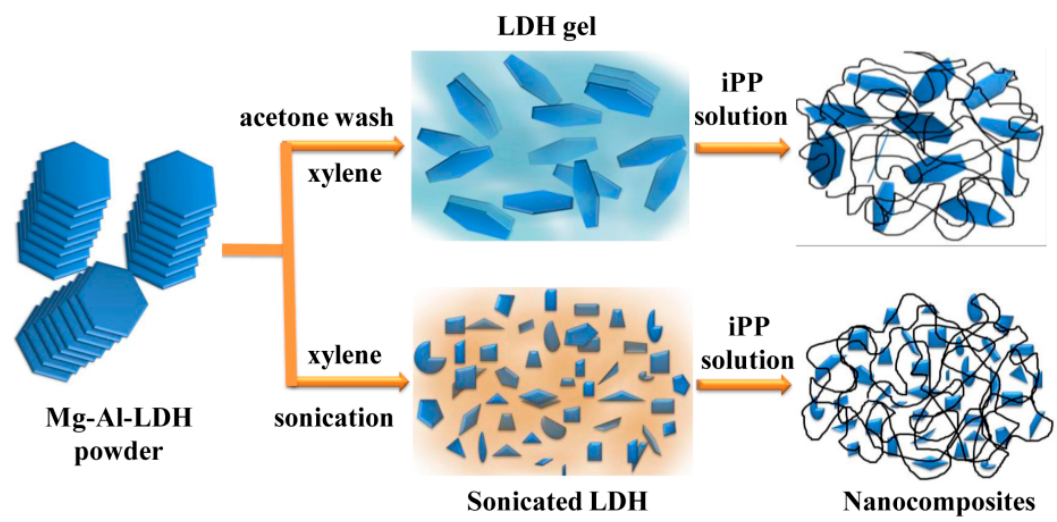
Figure 3. Graphic representation of the preparation of isotactic polypropylene / Mg–Al LDH layered double hydroxide nanocomposites. Reprinted (adapted) with permission from Nagendra, B.; MOHan, K.; Gowd, E.B. Polypropylene/layered double hydroxide (LDH) nanocomposites: Influence of LDH particle size on the crystallization behaviour of polypropylene 2015 American Chemical Society [64].